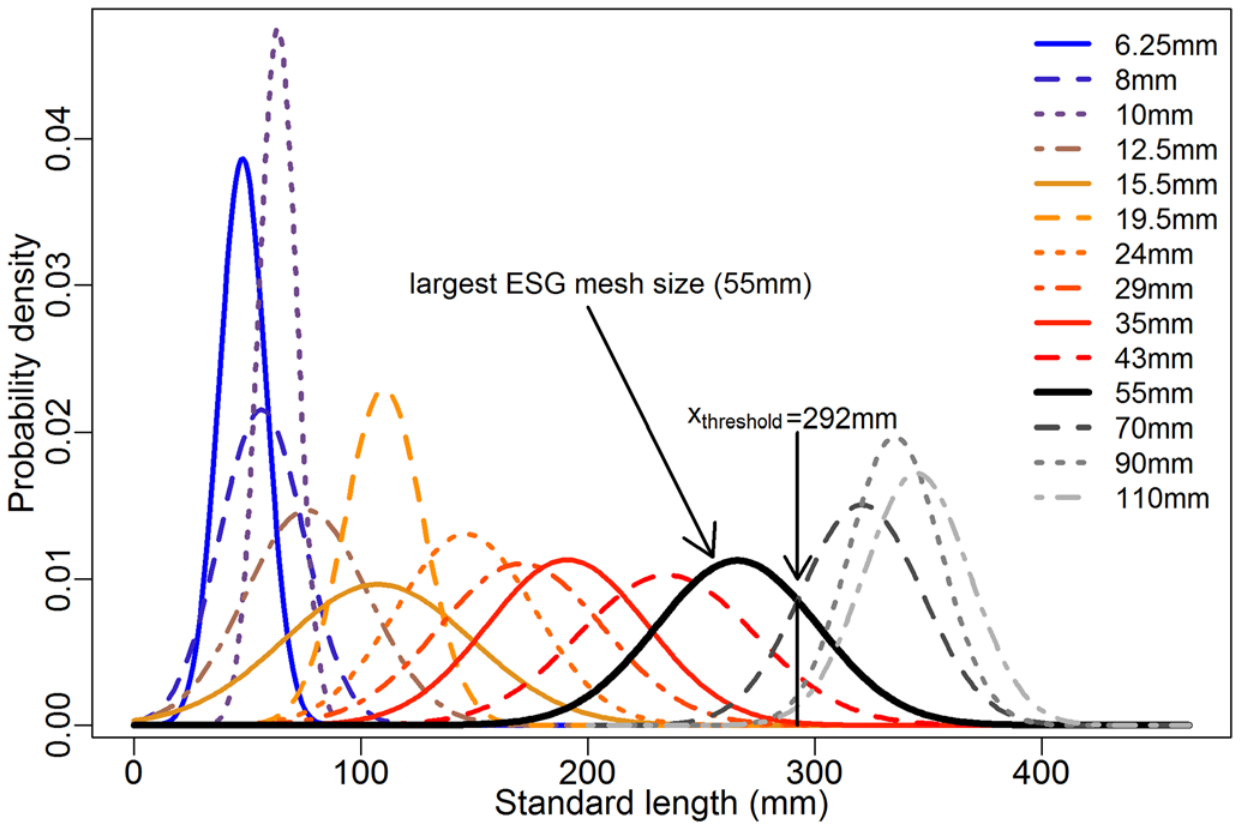
Fig 2. Mesh-specific length frequency distributions of bream captured in SMG in the Ř ímov Reservoir and LMG in all sampled water bodies. The selectivity curve of the 55mm mesh size (the largest mesh size of the ESG) is highlighted and the fish standard length corresponding to the intersection between the 55 and 70mm curves ( χ threshold ) is